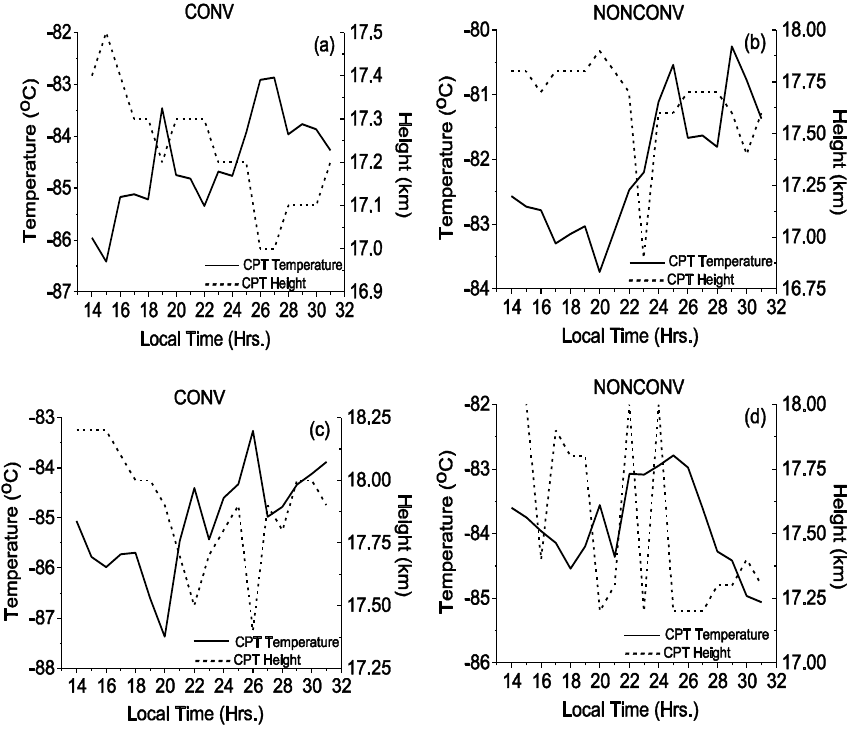
Fig. 3. (a) – (d) represents hourly variation of Cold Point Tropopause temperature (solid line) and height (dotted line) for (a) 30 Novem- ber 2005, (b) 6 December 2005, (c) 9 December 2005 and (d) 18 December 2005, respectively. On time scale, one hour is added to compensate the timing of the radiosonde to reach the level of tropopause.